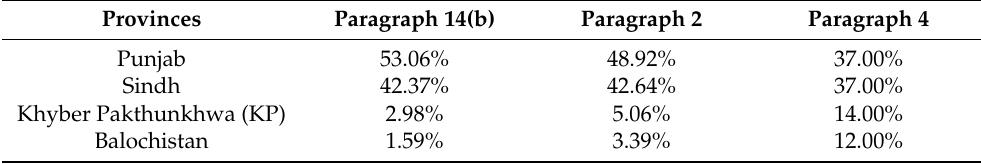
Table A1. Pakistan inter-provincial Water Apportionment Accord * Paragraph 14(b), 2 and